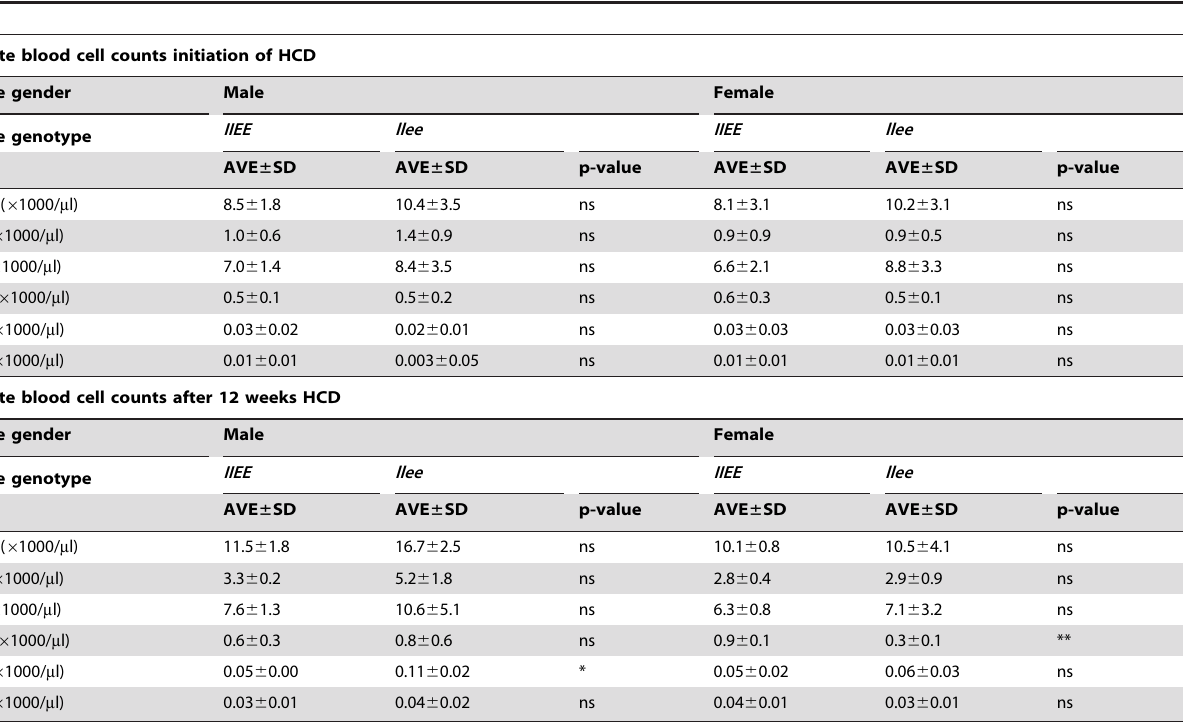
Table 1. White blood cell counts at initiation of HCD and after 12 weeks of HCD.